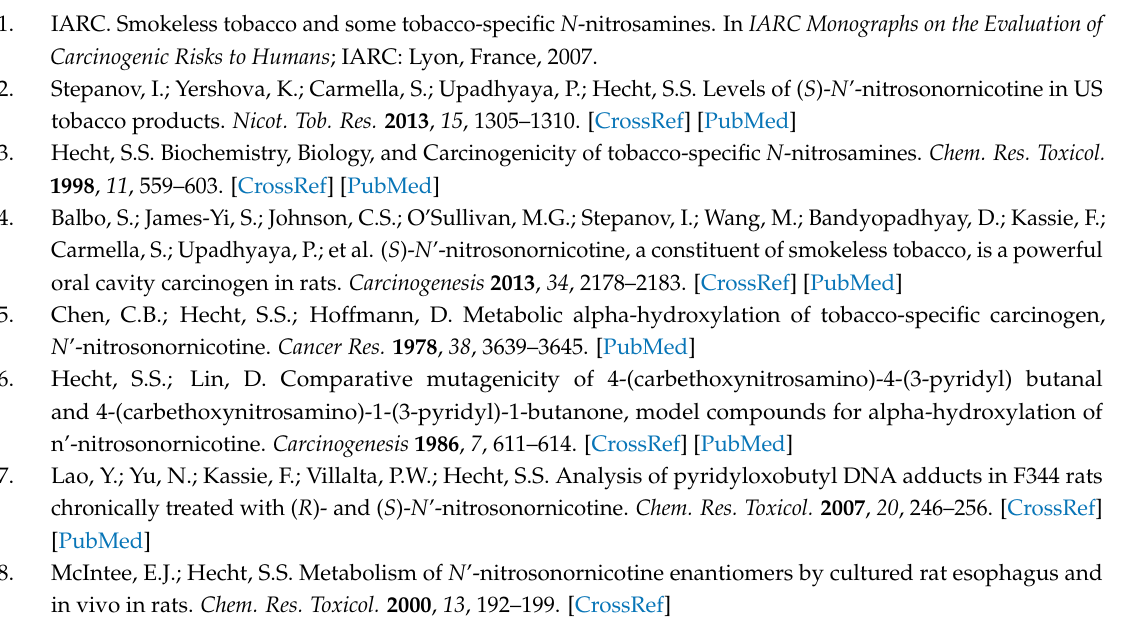
178/s1. Figure S1: Ramachandran Plot and statistics of modeled rat 2A3 enzymes, Figure S2: Optimized structures of 2-(R)-RC calculated by B3LYP and B3LYP-D3, Figure S3: Optimized geometries for 2 (cid:48) - and 5 (cid:48) -hydroxylation of (R)- and (S)-NNN catalyzed by Cpd I on low spin states. Bond lengths are given in angstroms, Figure S4: Optimized geometries for the decomposition of the hydroxylation products of (R)- and (S)-NNN. Bond lengths are given in angstroms, Figure S5: Self-docking structure of nicotine and CYP450 2A13, in which the brilliant blue nicotine is the native structure in the crystal complex and the pink nicotine is the redocked structure, Figure S6: Overlap of the rat 2A3 and the human 2A13 protein crystal structures, Figure S7: Detailed docking results of human CYP450 enzymes with NNN, Table S1: The absolute energies (AE: a.u.) and relative energies (RE: kcal/mol) for reaction species involved in 2 (cid:48) /5 (cid:48) -hydroxylation of (R)/(S)-NNN on doublet states, Table S2: The calculated spin densities for the reaction species involved in 2 (cid:48) /5 (cid:48) -hydroxylation of (R)/(S)-NNN on doublet states at UB3LYP-D3/B1 level, Table S3: The absolute energies (AE: a.u.) and relative energies (RE: kcal/mol) for reaction species involved in nonenzymatic decomposition of four α -hydroxyNNNs in the aqueous medium, Table S4: The absolute energies (AE: a.u.) and relative energies (RE: kcal/mol) for reaction species involved in alkylation of 2 (cid:48) -hydroxylation diazonium ion with ten DNA base site, Table S5: Comparison of free energies and optimized structures calculated for diazonium ions derived from 2 (cid:48) -hydroxylation of NNN binding with the nucleophilic O 6 position of N9-methylguanine and 2 (cid:48) - deoxyguanosine at the BSV//BSIII